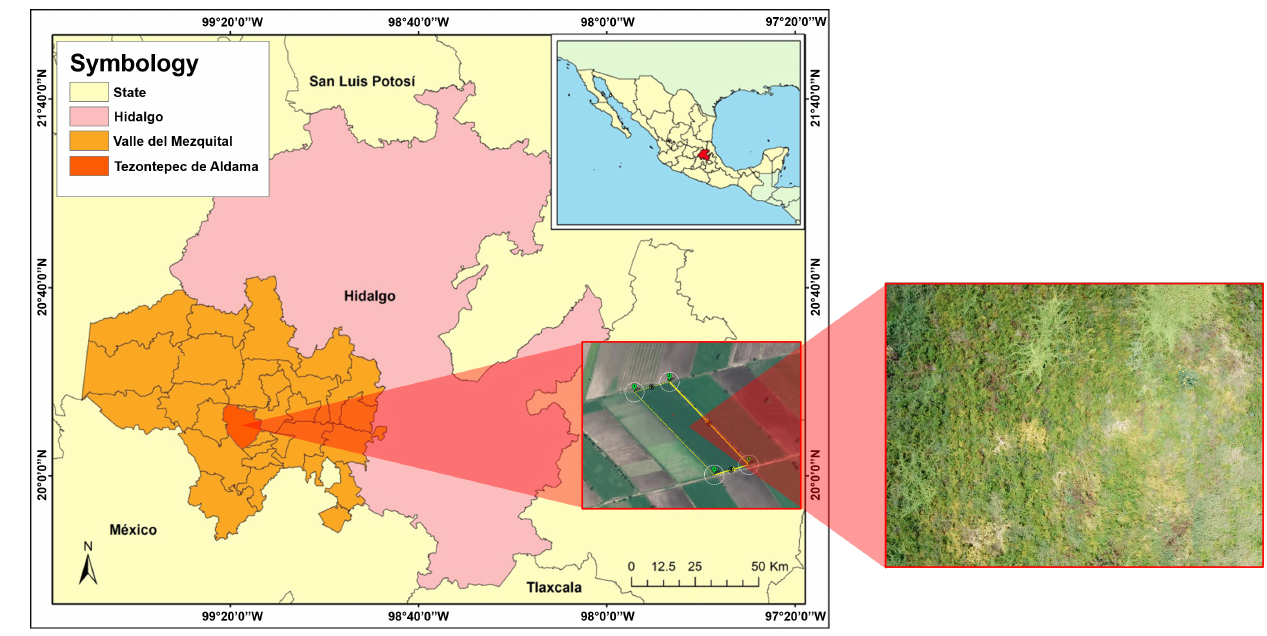
Figure 1. Schematic diagram of the study